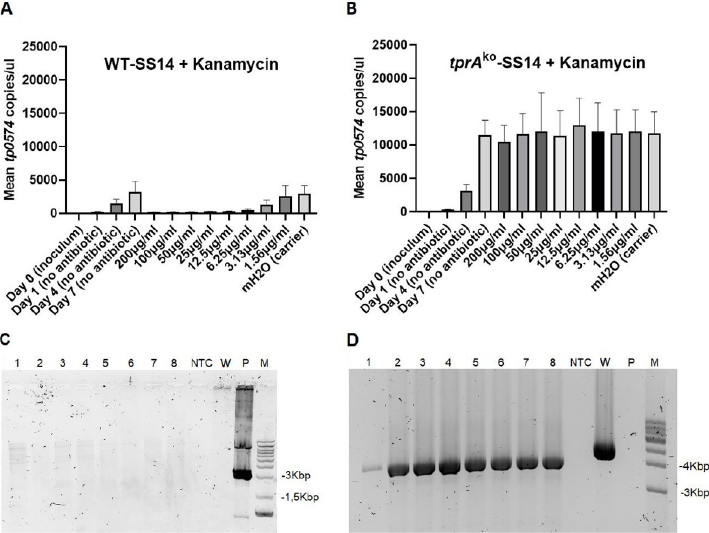
Fig 5. Kanamycin susceptibility assay for the wt-SS14 strain ( A ) and the tprA ko -SS14 ( B ). In panel A, values (mean ± SD) for Day 0 and Day 1 are 8.95 ( ± 1.6) and 209.6 ( ± 12.2), respectively. In panel B, values for Day 0 and Day 1 (mean ± SD) are 18.0 ( ± 1.8) and 315.6 ( ± 14.7), respectively. mH2O: molecular grade water. DNA was extracted from the 8 replicate tprA ko -SS14 cultures propagated in 200 μ g/ml of kanamycin and tested with primers targeting the pUC57 vector backbone (panel C ) used for transformation, showing lack of amplification. Wells 1–8: DNA template from the 8 replicate cultures; NTC: no template control; N: wt-SS14 strain DNA; P: p tprA arms- tp0574 prom- kan R plasmid DNA template; M: molecular size marker. Expected amplicon size in ~3Kb. ( D ) DNA was extracted from the 8 replicate tprA ko -SS14 cultures propagated in 200 μ g/ml of kanamycin and tested with primers targeting T . pallidum genomic region right outside of the tprA homology arms (primers in Table 1), showing that in the tprA ko -SS14 strain a smaller amplicon is obtained due to the replacement of tprA by the kan R gene, which is approximately 1Kb shorter in size. Wild-type SS14 DNA template yielded a longer amplicon due to an intact tprA locus still in place. No amplification was detected using the transformation plasmid DNA control. NTC: no template control; W: wt-SS14 strain DNA; P: p tprA arms- tp0574 prom- kan R plasmid DNA template; M: molecular size marker (Kbp).